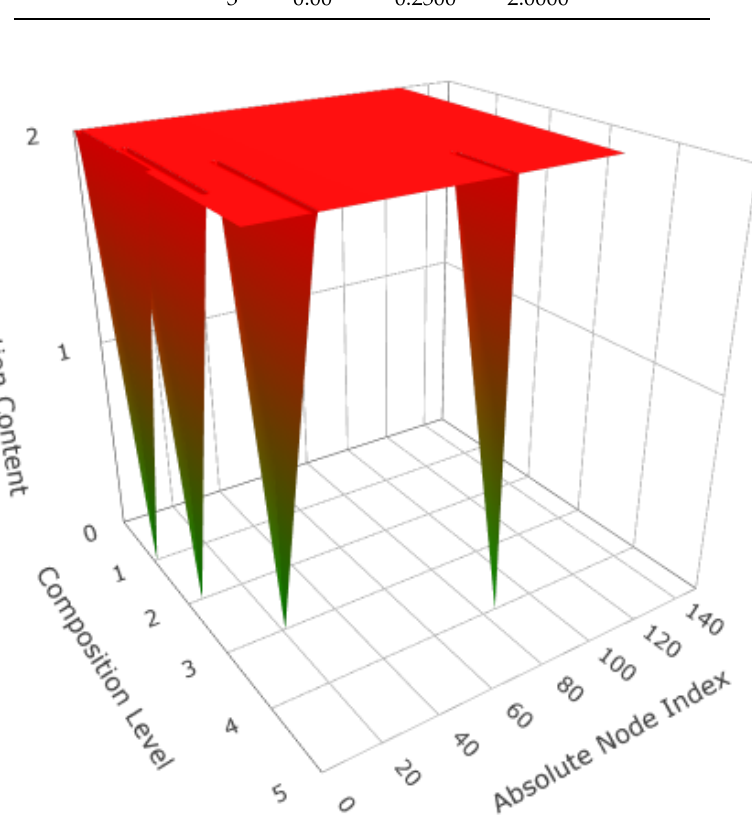
Figure 6. DPath Information for a DSpace traversal using Test Set